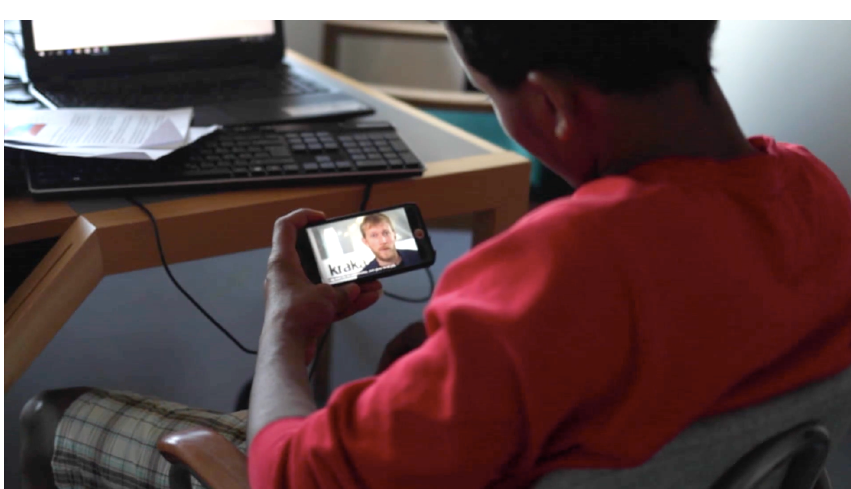
Figure 20. Shirak watches videos about integration, broadcast by the Danish national TV station, DR. In the videos, politi- cians and citizens explain their opinions on what they think is good integration. March